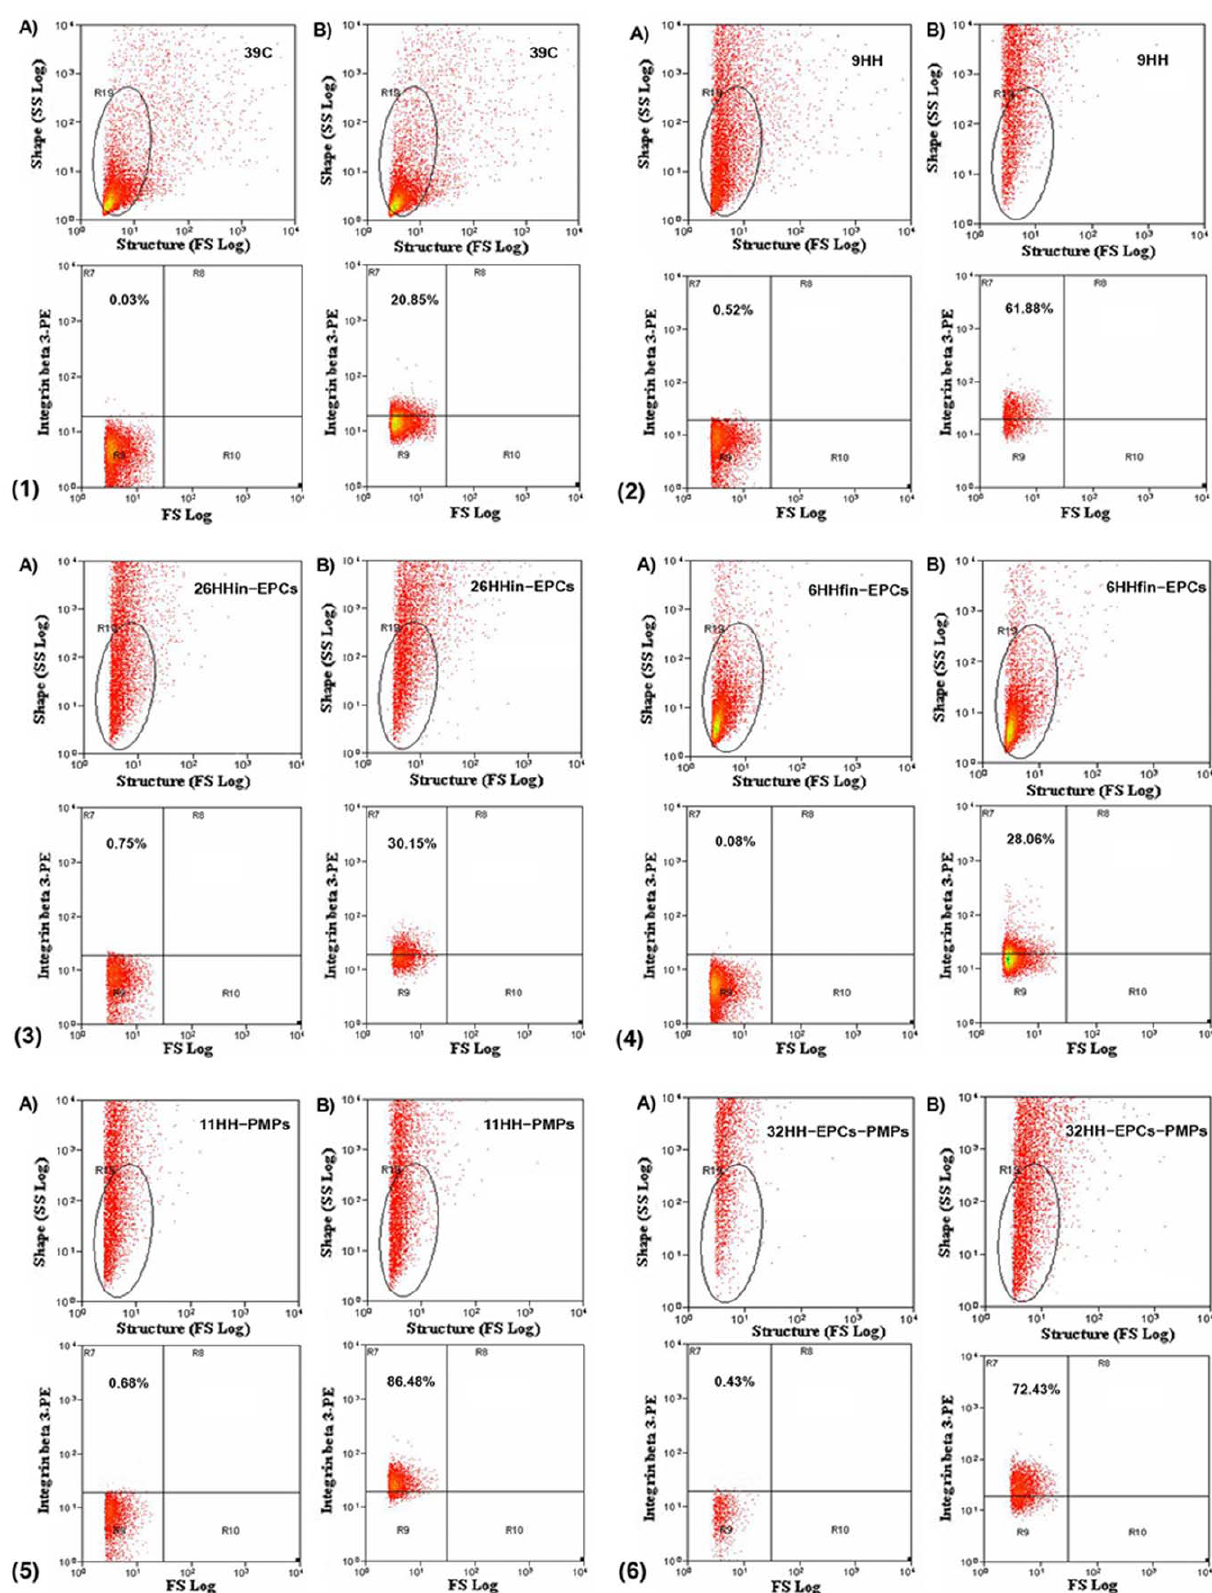
Figure 1. The flow cytometric detection on platelet activated Integrin b - 3 (1): control group, C (2): hypertensive- hypercholesterolemic (HH) group; (3): prevention group, HHin-EPCs (4) regression group, HHfin-EPCs (5) HH treated with PMPs group, HH-PMPs and (6) HH treated with EPCs